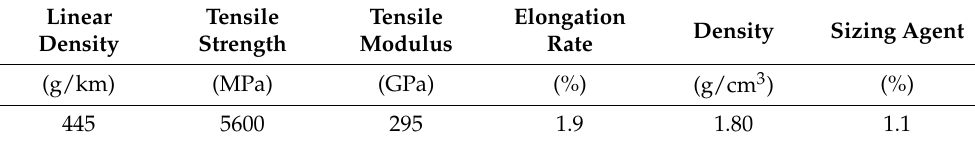
Table 2. Properties of HF40C